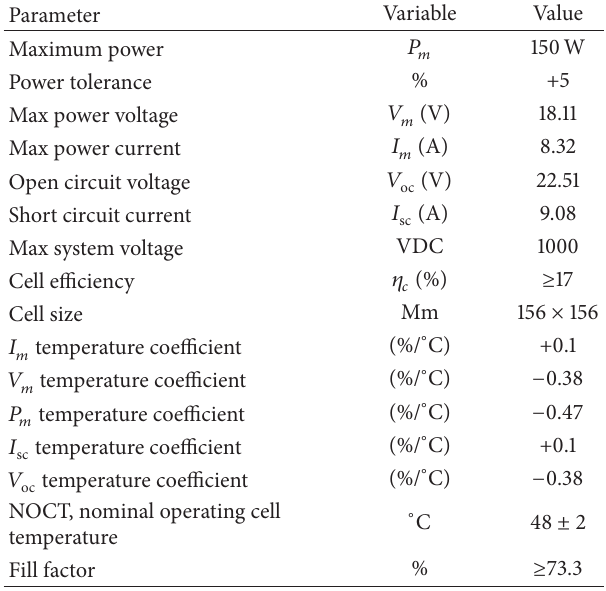
Table 4: Typical electrical characteristics of BSM-150 PV